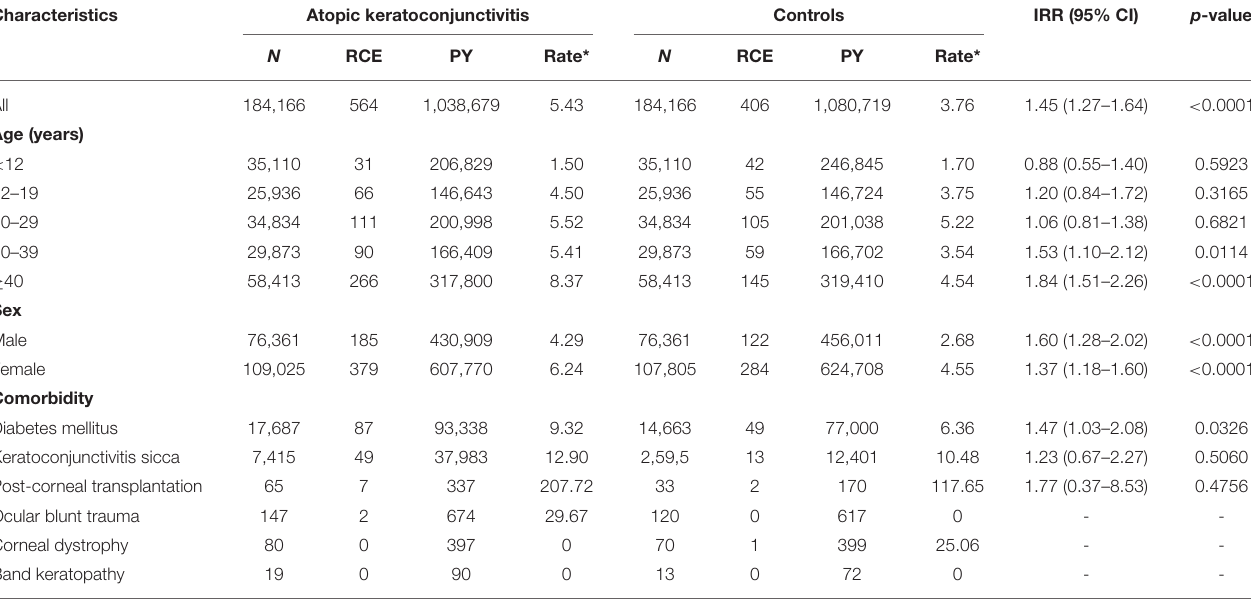
TABLE 2 | Risk of recurrent corneal erosion (RCE) in the atopic keratoconjunctivitis and control groups. Characteristics Atopic keratoconjunctivitis Controls IRR (95% CI) p -value